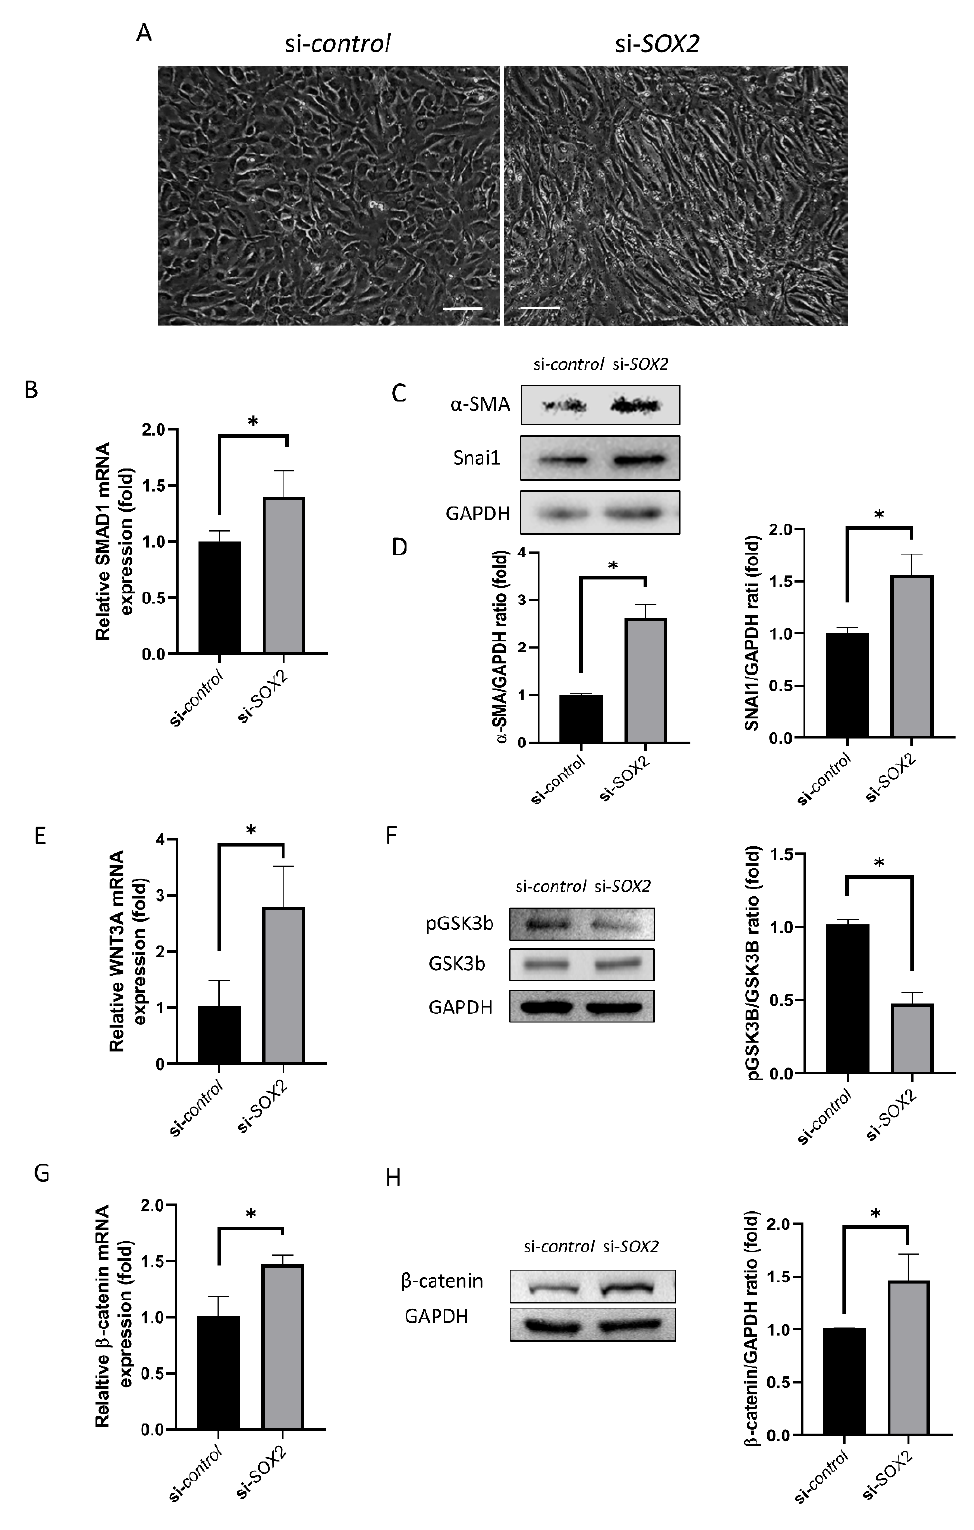
Figure 2. Endothelial-mesenchymal transition and WNT signaling pathway. ( A ) Cell shape in si-control and si-SOX2 cells. Scale bar denotes 150 µ m. ( B ) SMAD1 mRNA expression. ( C ) α -SMA level determined by Western blotting. ( D ) SNAI1 level determined by Western blotting. ( E ) WNT3A mRNA expression. ( F ) GSK3 β activation determined by Western blotting. ( G , H ) β -catenin level determined by RT-PCR and Western blotting. * indicates statistical significance by independent t -test.